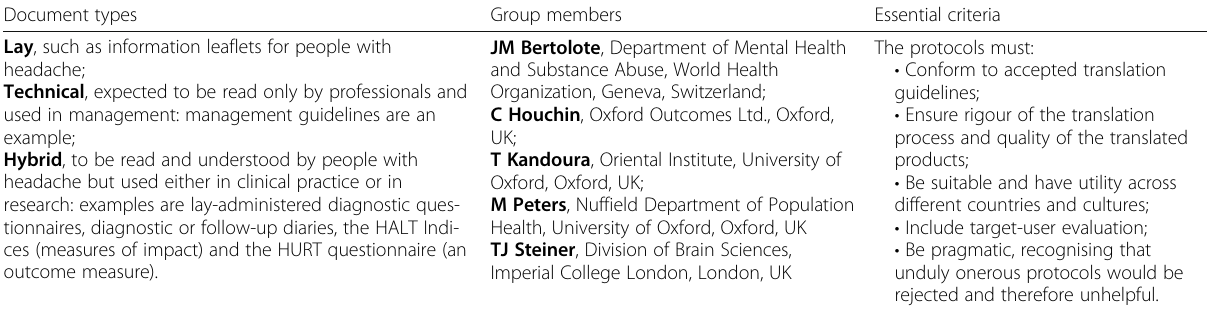
Table 19 The three types of document produced for the Global Campaign, the expert consensus group and their five essential